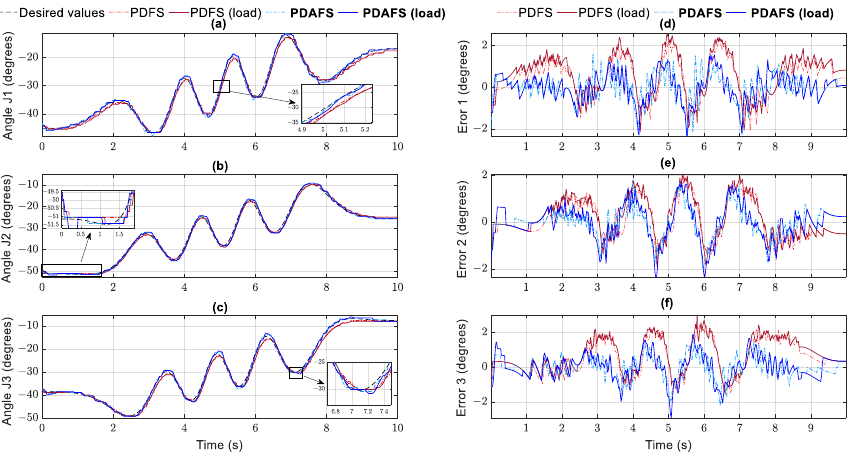
Figure 17. Helix trajectory performance in joint space: ( a ) joint 1; ( b ) joint 2; ( c ) joint 3 and tracking error: ( d ) joint 1; ( e ) joint 2; ( f ) joint 3 in case 2.